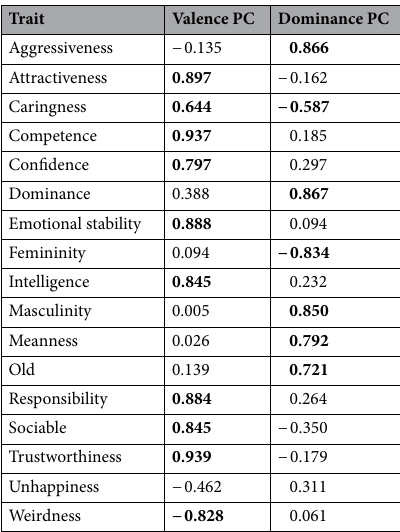
Table 2. Correlations between each trait and scores on the Valence and Dominance components in Study 1. Correlations with absolute values larger than 0.5 are bolded.